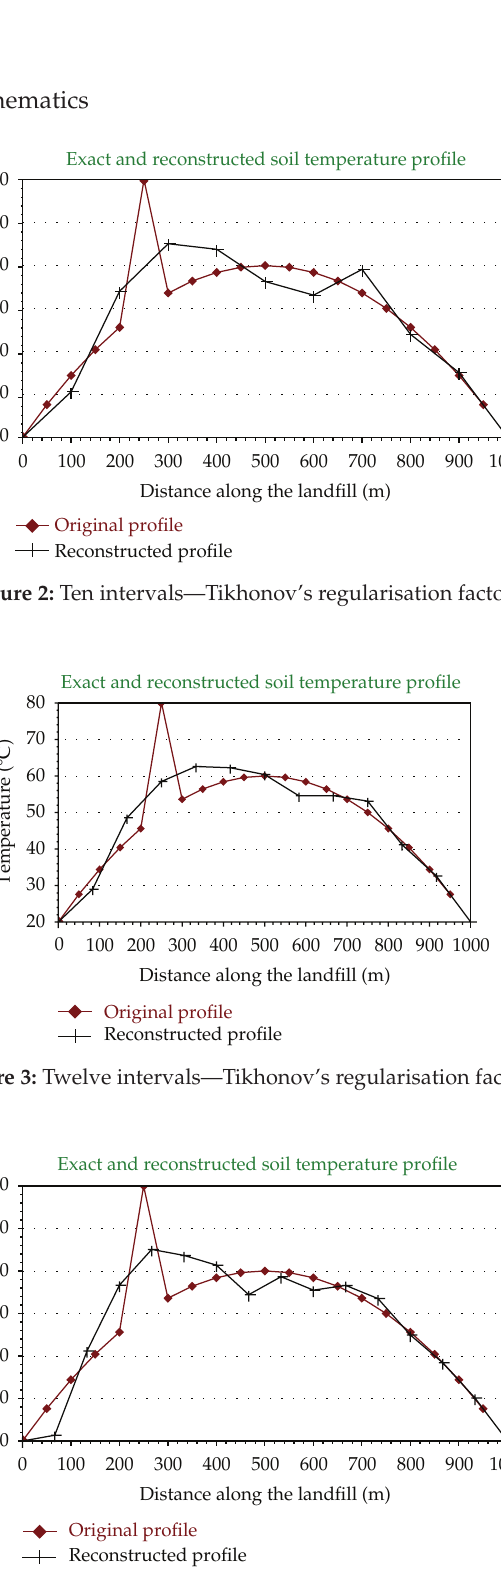
Figure 4: Fifteen intervals—Tikhonov’s regularisation